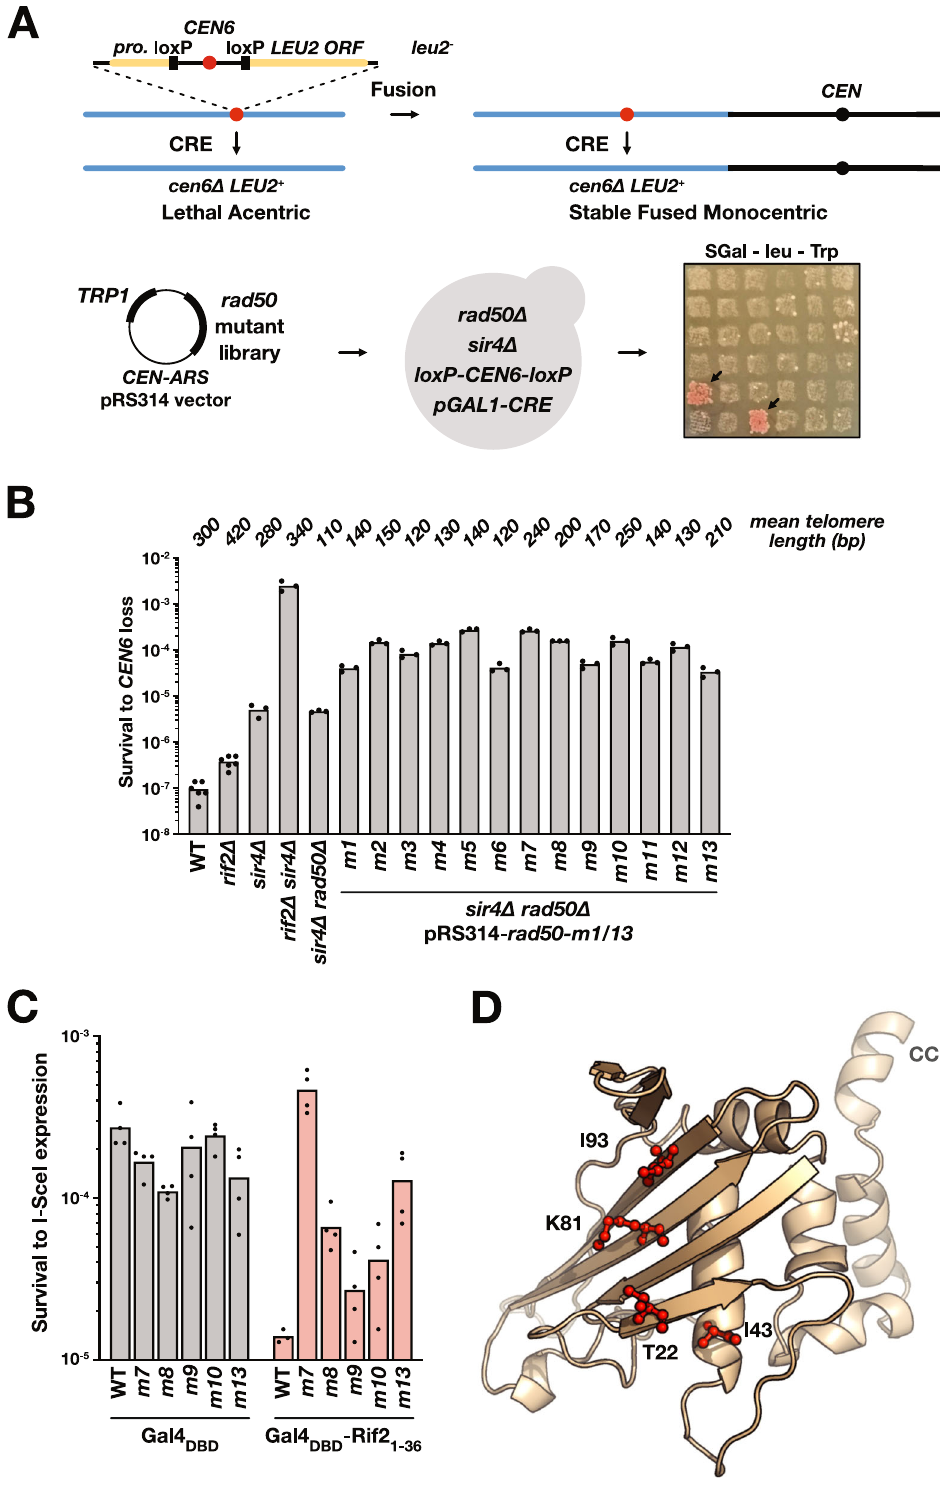
We expected two classes of mutants: (i) mutants whose increased fusion frequency is simply a consequence of a telomere shortening caused by a partial loss of function of MRX and (ii) mutants more speci fi cally impacting Rif2 inhibition and better retaining MRX functions and the ability to elongate telomeres. Therefore, as a secondary screen, we determined the